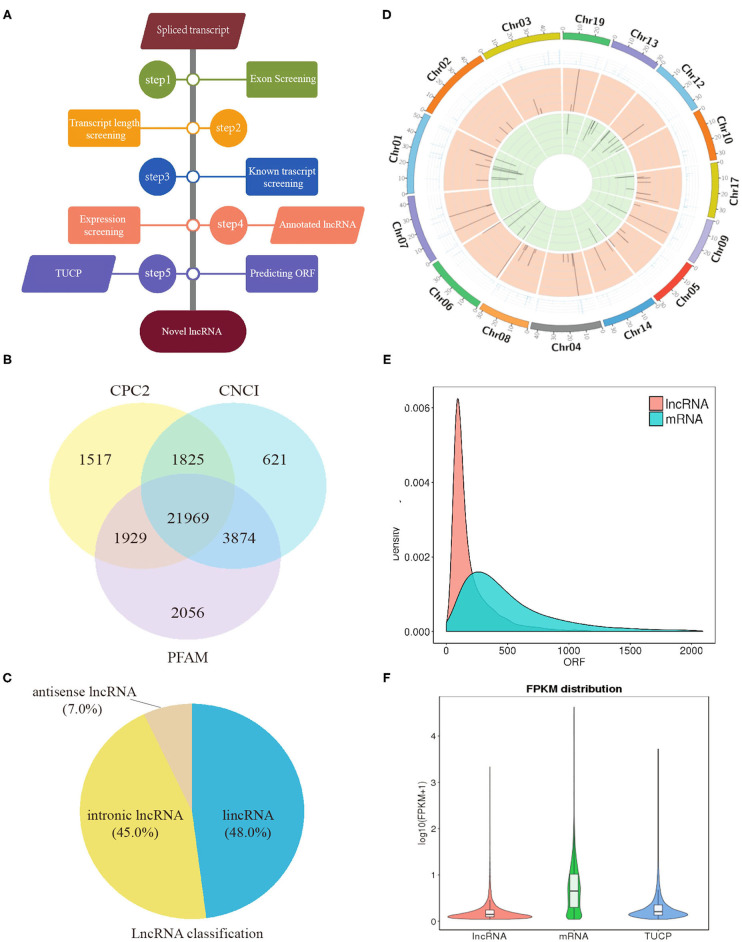
Identification of lncRNA in intermuscular bones. (A) Workflow for the preparation and analysis of lncRNA libraries. (B) Venn diagram analysis of lncRNAs identified from three software. (C) The classification of lncRNAs. (D) The distribution of lncRNAs in different chromosomes: the outermost circle is the chromosome; the second circle is the FPKM value of the samples on the corresponding chromosome; the third and fourth circles are the distribution of the significantly upregulated genes and the significantly downregulated genes in IB_III compared to IB_I on the chromosome, respectively. (E) Density distribution of lncRNA and mRNA with different ORF lengths. (F) Violin diagram of the expression of lncRNA, mRNA, and TUCP transcripts.